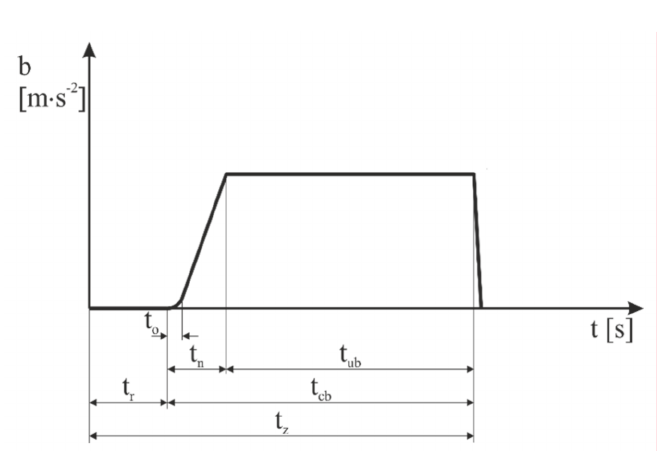
Figure 1. A theoretical course of braking [74].